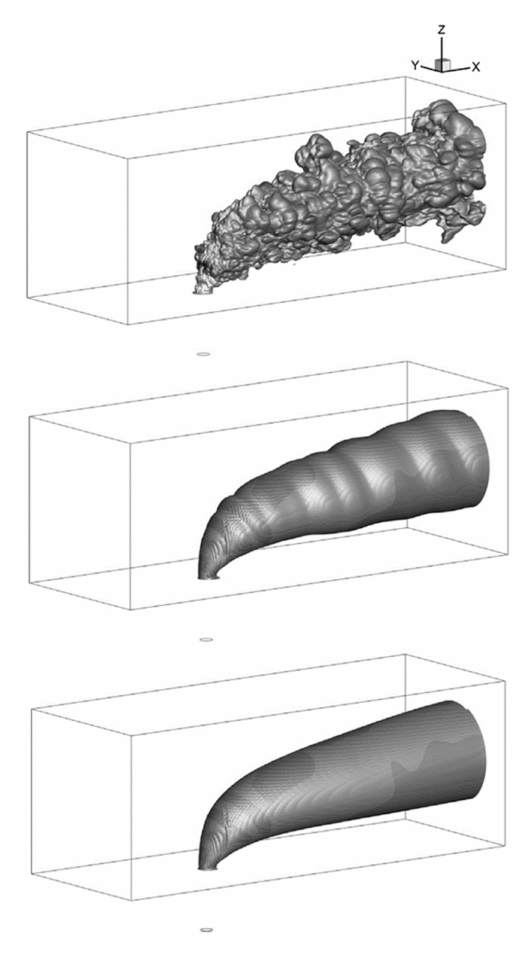
Figure 20. Comparison the ability of different simulations methods from top to bottom, large eddy simulation (LES), unsteady RANS (URANS), and Reynolds-averaged Navier–Stokes (RANS) for the prediction of coherent structures